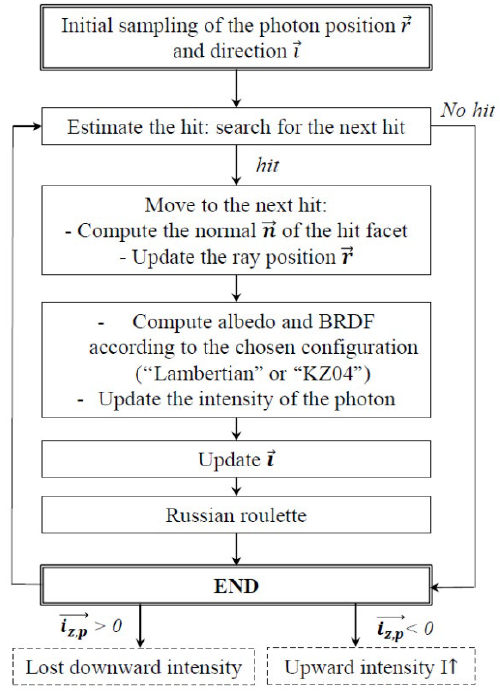
Figure 4. Flow chart of a photon path in the RSRT algorithm. i is the incident direction of the photon, and i z,p is the z -axis compo- nent of the photon at the end of its